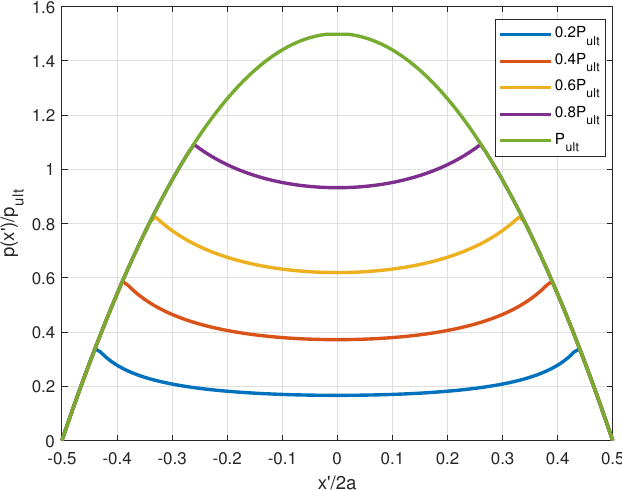
Figure 6. Example normal contact traction field distributions for an elastoplastic rigid punch foun- dation loaded on the surface of a dry, cohesionless sand (from Abdullah [31]). The traction field evolves inwards towards the bounding quadratic curve for a load P ult , determined by the classical bearing capacity theory [37]. The traction fields are normalized by the ultimate average pressure p ult = P ult /2 a